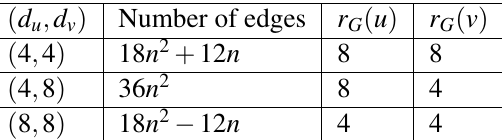
Table 1 Edge partition of octahedral network